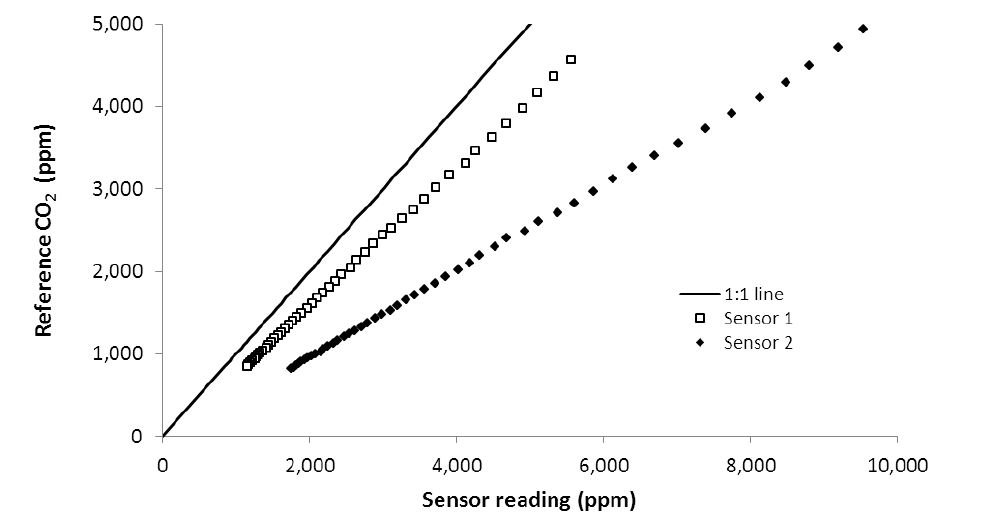
concentrations (range from 1000 to 5000 2